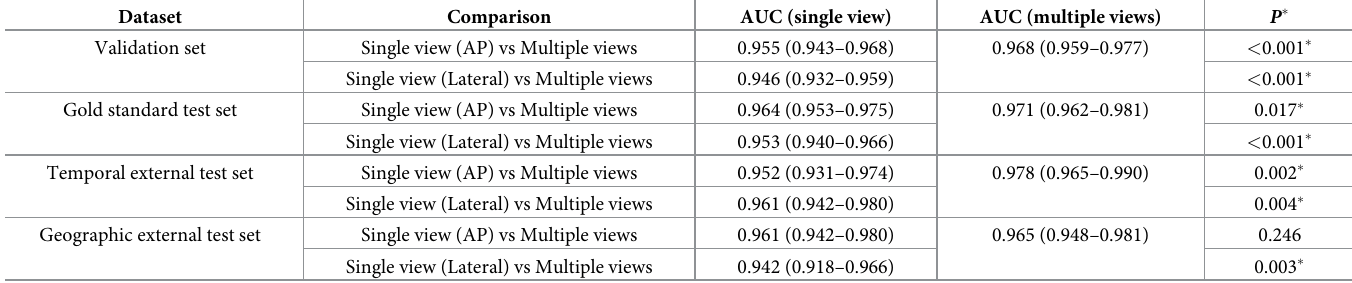
Table 2. Comparison of the diagnostic performance between the algorithm using single view and the algorithm using multiple views in each data set based on labels by conventional radiography. Dataset